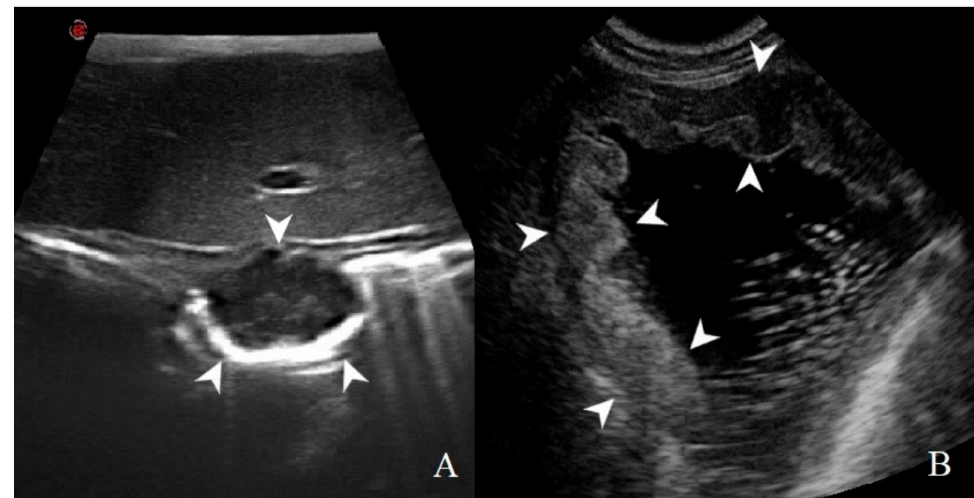
Figure 3. Thickening localization classified as: ( A ) focal: a transmural, prevalent hypoechoic mass (arrowheads) with loss of layering was identified in a dog with gastric GIST; ( B ) diffuse: wall hyperechoic thickening (arrowheads) with complete loss of layers definition is present in most of the stomach in this dog affected by adenocarcinoma.